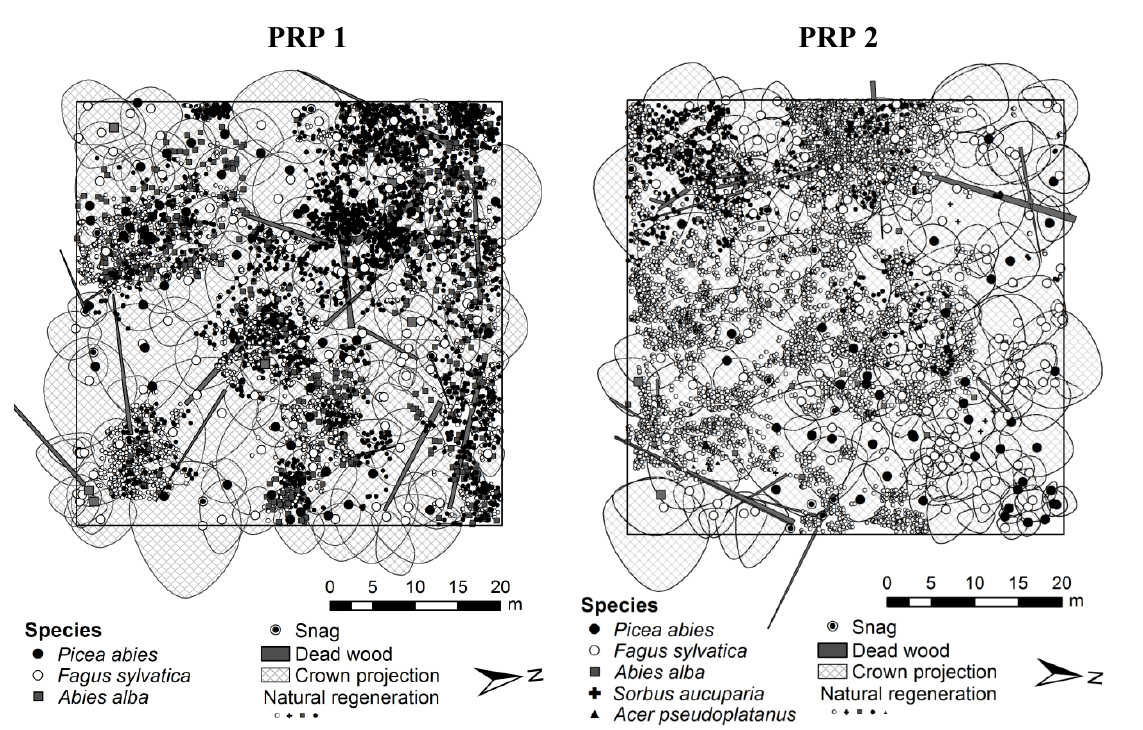
Figure 2. Horizontal structure of the forest stand on PRP 1 (fenced) and PRP 2